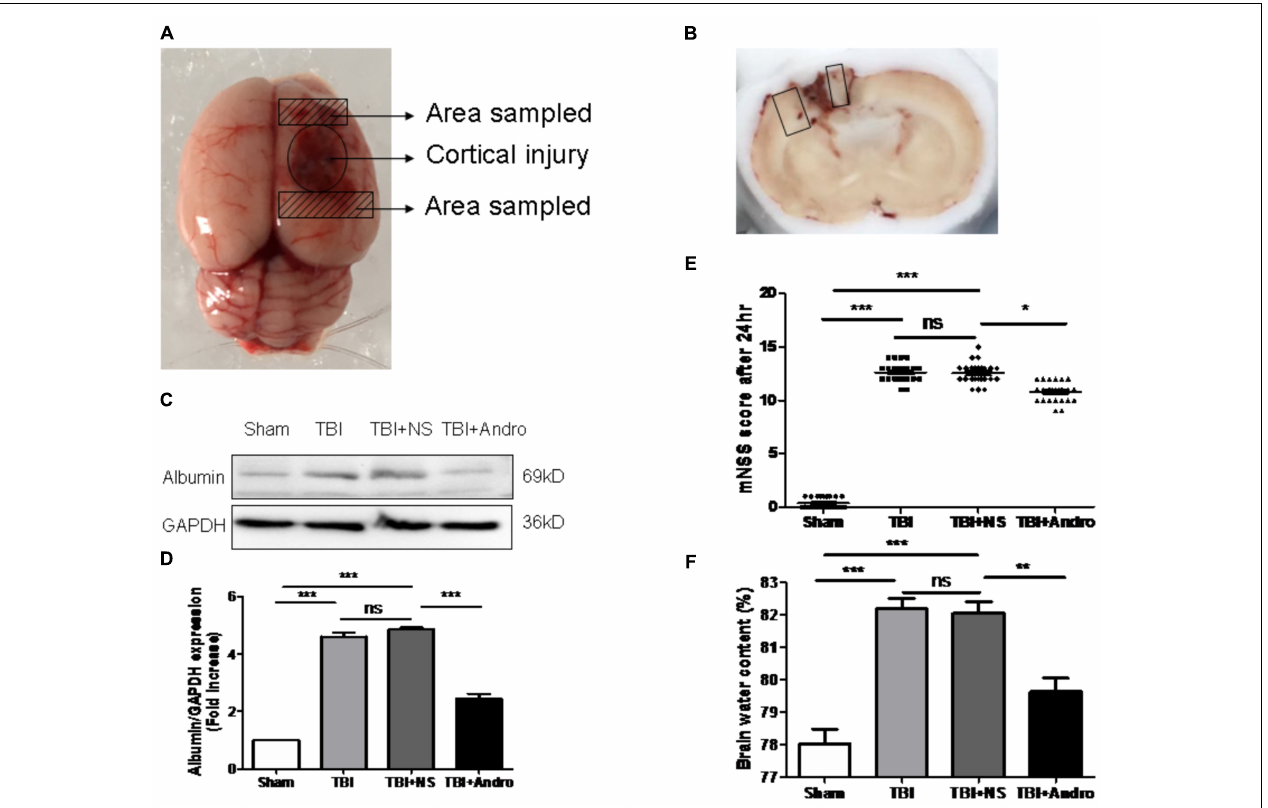
FIGURE 1 | Andro treatment improved neurological function, reduced blood-brain barrier (BBB) disruption and cerebral edema after TBI. (A) A schematic image of the cortical contusion area induced by weight-dropping model of traumatic injury and the sampled area around the injured brain. (B) A schematic of a coronal section and the microphotographed areas used in immunofluorescence staining are marked with a box. (C) The expression level of albumin in peri-contusive cortex was examined by Western blot analysis at 24 h after TBI. (D) Relative expression levels of albumin were calculated based on densitometry analysis. The mean values of albumin in the sham group were normalized to 1.0. (E) Neurological function was measured by mNSS tests at 24 h after TBI. (F) Brain water content of each group was measured at 24 h after TBI. Data are presented as the mean ± SD. ∗ p < 0.05, ∗∗ p < 0.01 ∗∗∗ p < 0.001, ns p > 0.05; n = 6 in each